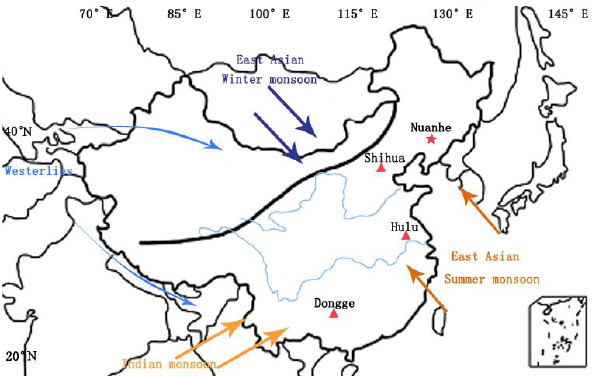
Fig. 1. Location of Nuanhe Cave. The orange arrows show different sub-systems of Asian summer monsoon, blue arrows indicate East Asian winter monsoon and westerly winds, respectively. The bold line illustrates the northern limit of summer monsoon. The red star and triangles indicate the location of Nuanhe Cave and other cave sites mentioned in this